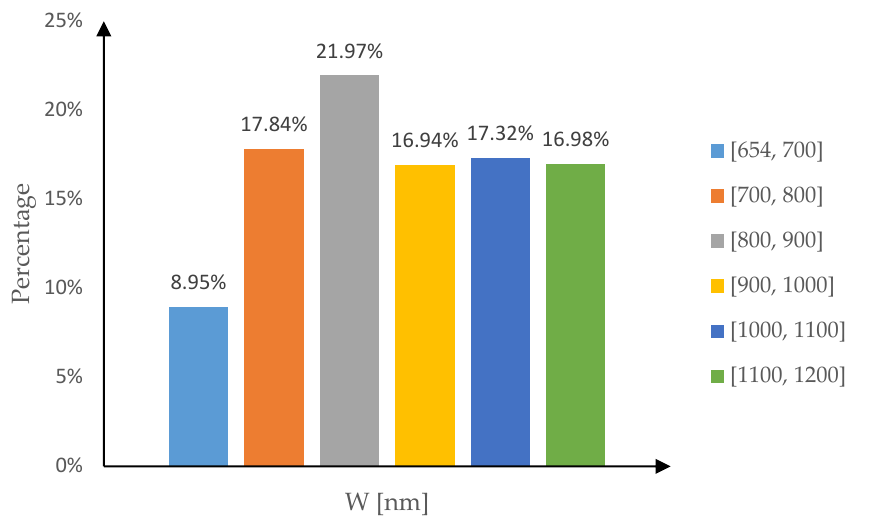
Figure 5. Gate width distribution of the training data with an RE greater than µ + 3 σ . The training data with an RE greater than µ + 3 σ accounted for 0.89% of all training data.